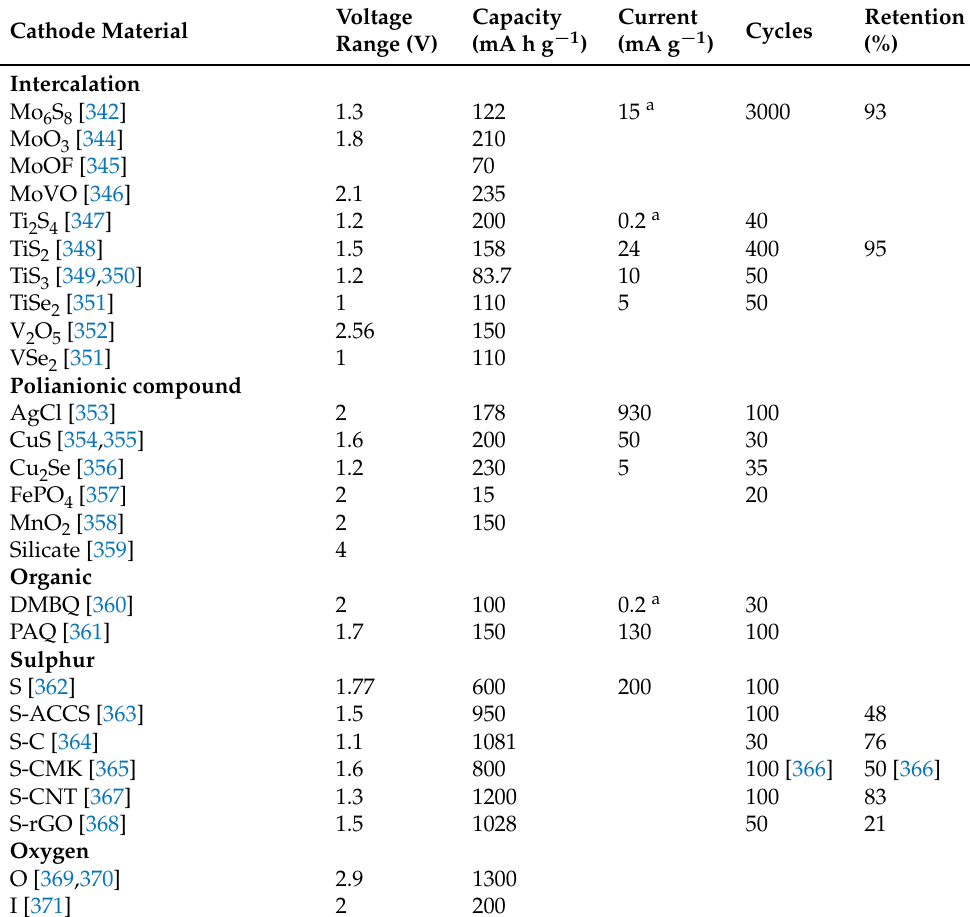
Table 13. Cathode materials for Mg-based